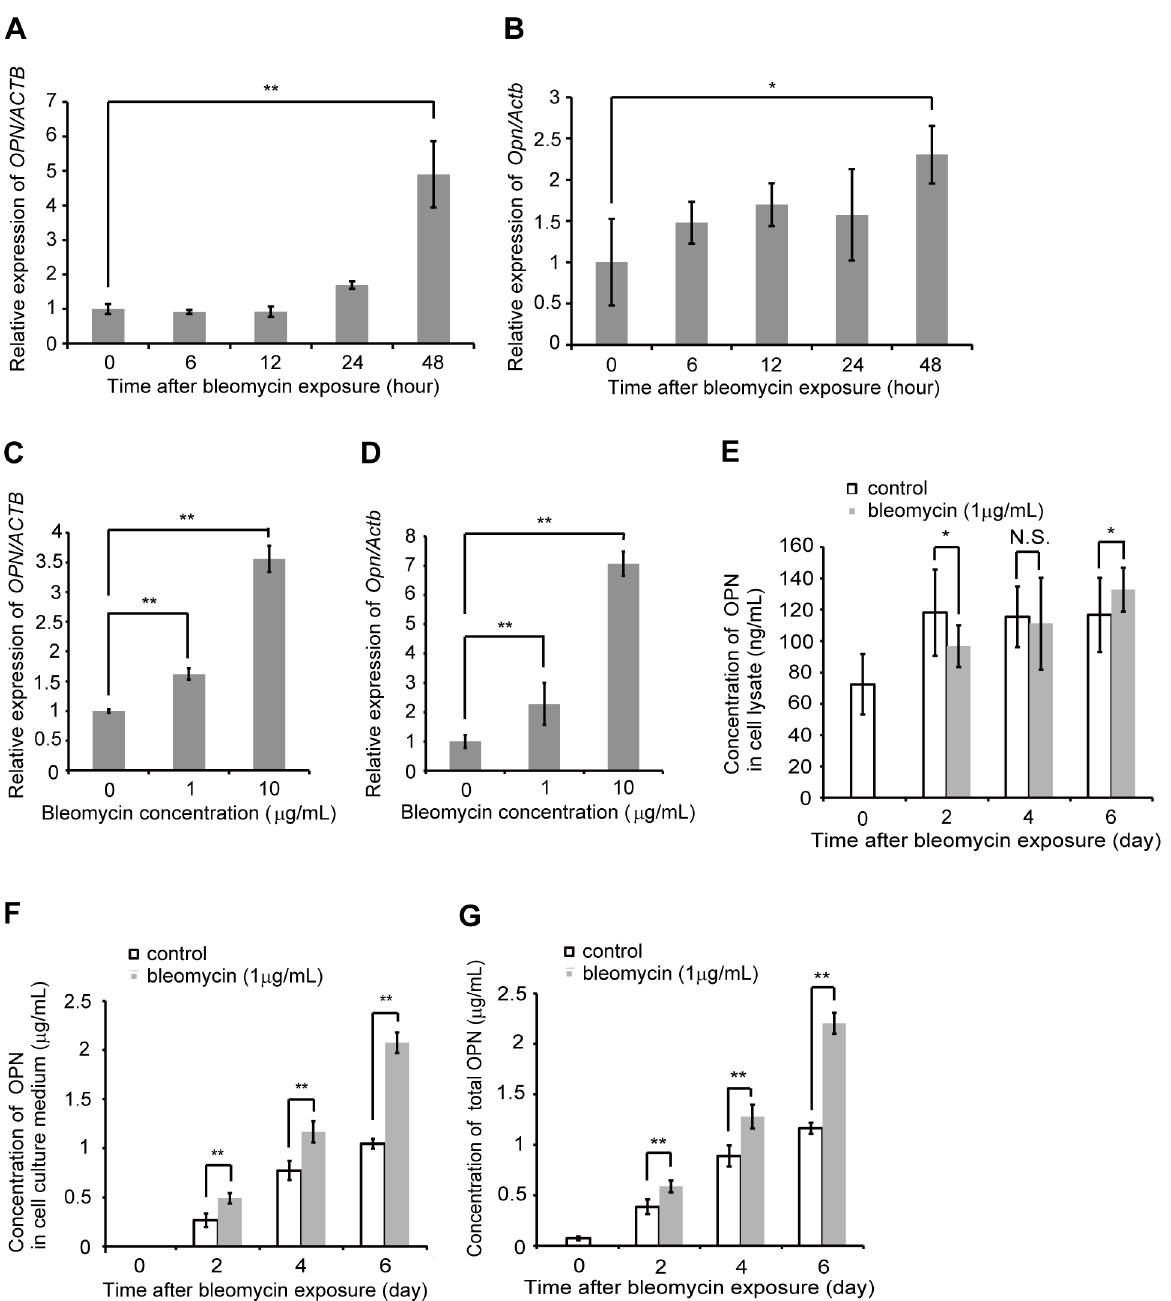
Figure 1. Effect of bleomycin on OPN expression in type II alveolar epithelial cell lines. (A) A549 were exposed to 1 m g/mL bleomycin for 0, 6, 12, 24 and 48 h. OPN mRNA was assessed by qRT-PCR. (B) MLE12 were exposed to 1 m g/mL bleomycin for 0, 6, 12, 24 and 48 h. Opn mRNA was assessed by qRT-PCR. (C) A549 were exposed to 0, 1 and 10 m g/mL bleomycin for 48 h. OPN mRNA was assessed by qRT-PCR. (D) MLE12 were exposed to 0, 1 and 10 m g/mL bleomycin for 48 h. Opn mRNA was assessed by qRT-PCR. (E, F and G) A549 were exposed to 1 m g/mL bleomycin. (E) The cells were lysed at 0, 2, 4 and 6 d. OPN concentrations in cell lysates were determined by ELISA. (F) The cell culture supernatants were collected at 0, 2, 4 and 6 d. OPN concentrations in cell culture media were determined by ELISA. (G) Total OPN concentrations in cell lysates and cell culture media were determined by ELISA. Data are presented as mean 6 S.E. *, P , 0.05; **, P , 0.01. pathway. ERK1/2 phosphorylation was induced in A549 after exposure, without significant changes to total Erk1/2 protein levels 24 h of exposure to 50 nM doxorubicin, without significant (Figure S5). changes to total ERK1/2 protein levels (Figure 3C). To confirm To determine whether the ERK-dependent signaling pathway these results, MLE12 were exposed to 50 nM doxorubicin. In was responsible for doxorubicin-mediated expression of OPN, we MLE12, Erk1/2 phosphorylation was induced after 36 h of exposed both cell lines to 50 nM doxorubicin for 48 h after